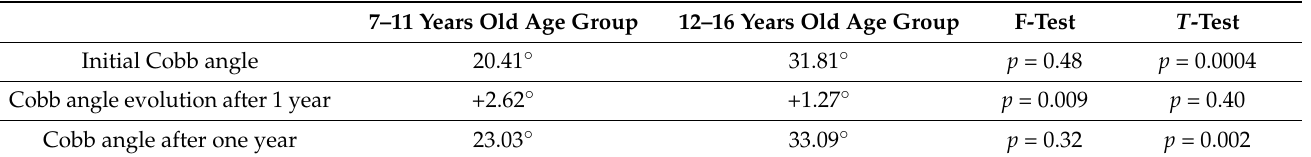
Table 5. Analysis of the Cobb angle by age groups (from 7–11 years old and 12–16 years old) at the starting point, after one year of treatment, and its